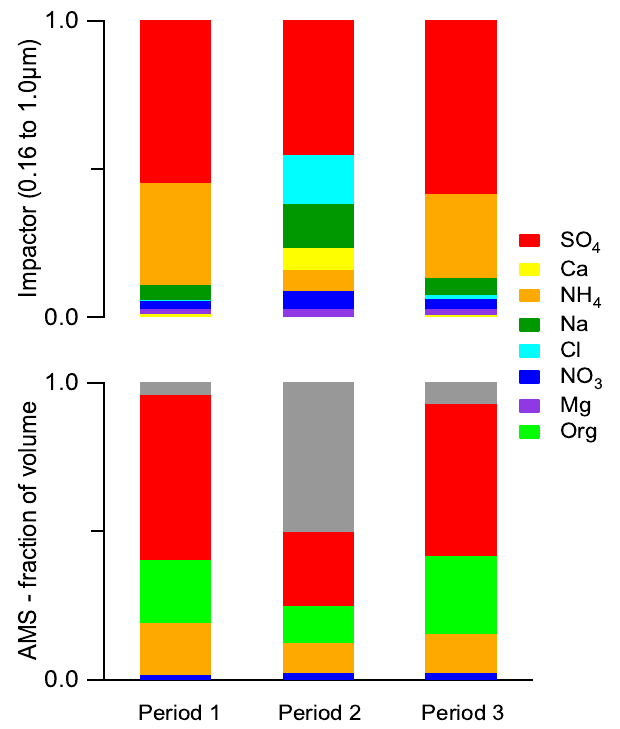
Fig. 3. Aerosol composition for the 3 case study periods. The top panel shows the mass fraction of each ion normalised to sulphate from analysis of the impactor samples in the 0.16µm to 1.0µm stage averaged over each study period. The bottom panel shows the composition (converted to volume) measured by the AMS averaged over each period as a fraction of the averaged total aerosol volume measured by the DMPS. The individual compounds are indicated by colour: sulphate (red), ammonium (orange), calcium (yellow), sodium (dark green), chloride (light blue), nitrate (dark blue), mag- nesium (purple) and organics (light green). The grey bands indi- cates the differences between the AMS and DMPS volumes.